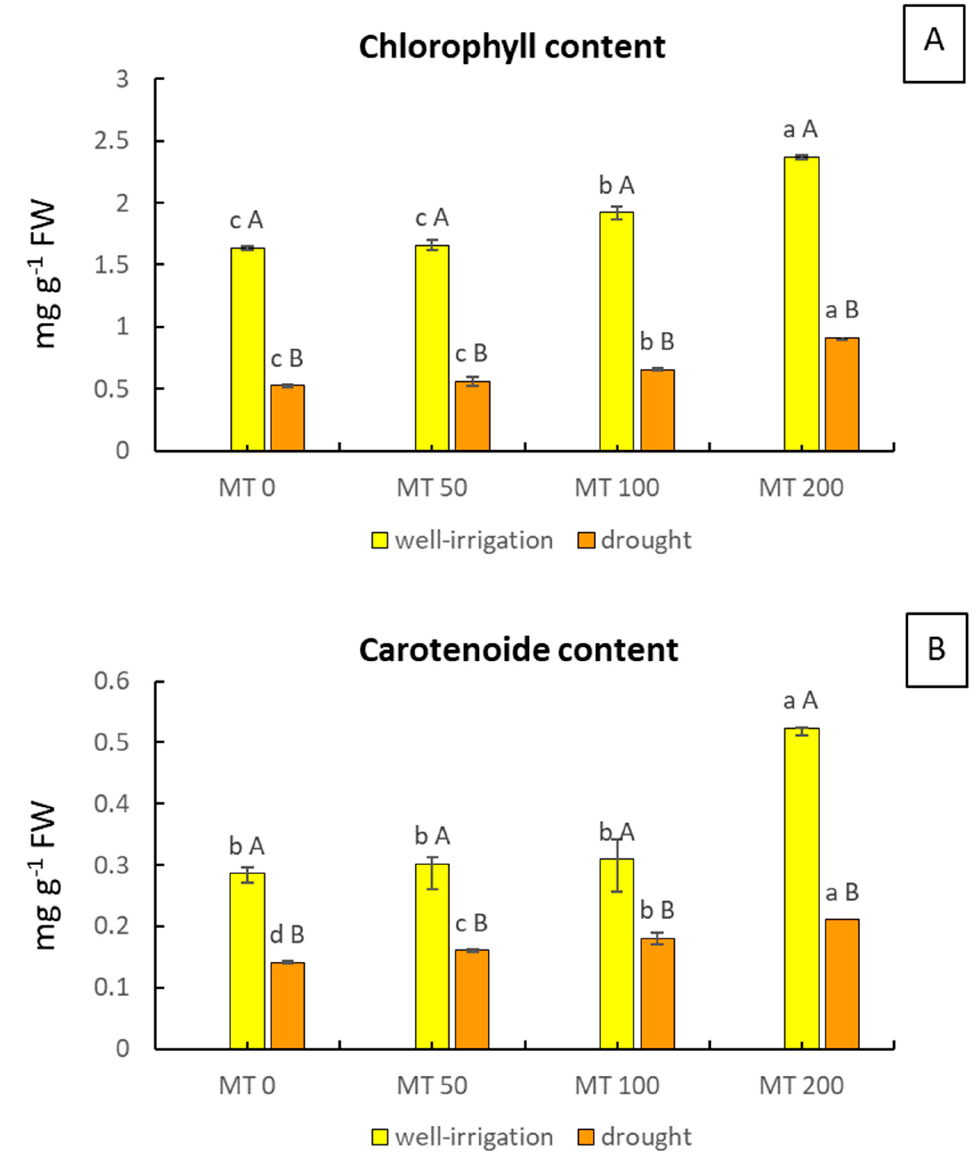
Figure 3. Effect of exogenous melatonin on the total chlorophyll (mg g − 1 , FW) ( A ) and carotenoid (mg g − 1 , FW) ( B ) content of R. asiaticus under drought stress conditions. ( A ) Chlorophyll content in leaves (mg/g fresh weight). ( B ) Carotenoid content in leaves (mg/g fresh weight). MT0, well-watered and drought-stressed plants without MT treatment; MT50, MT100, and MT200, treatment with MT at different concentrations (50, 100, and 200 µ M, respectively) under well-irrigated and drought conditions. Lowercase letters: comparison of MT concentrations under fixed irrigation treatments;